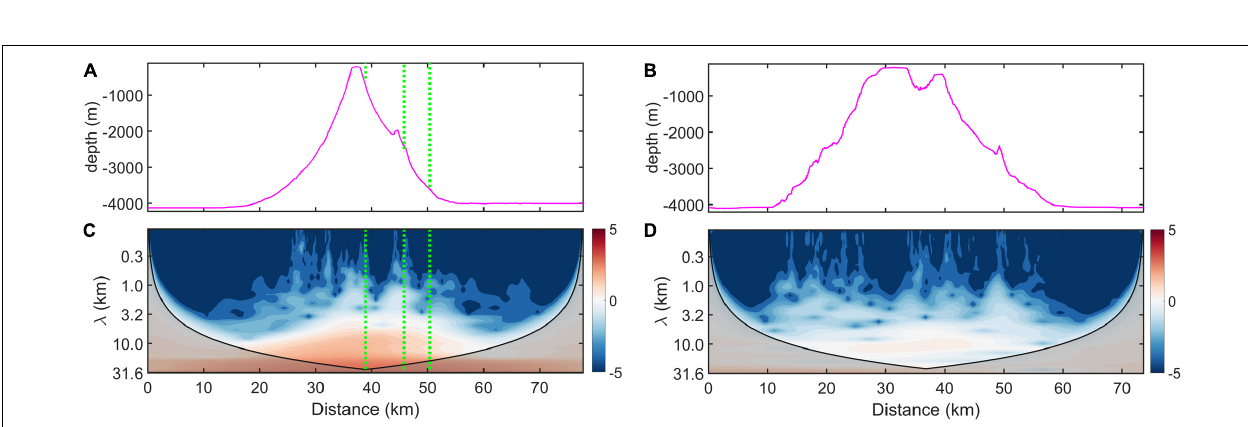
Frontiers in Marine Science |